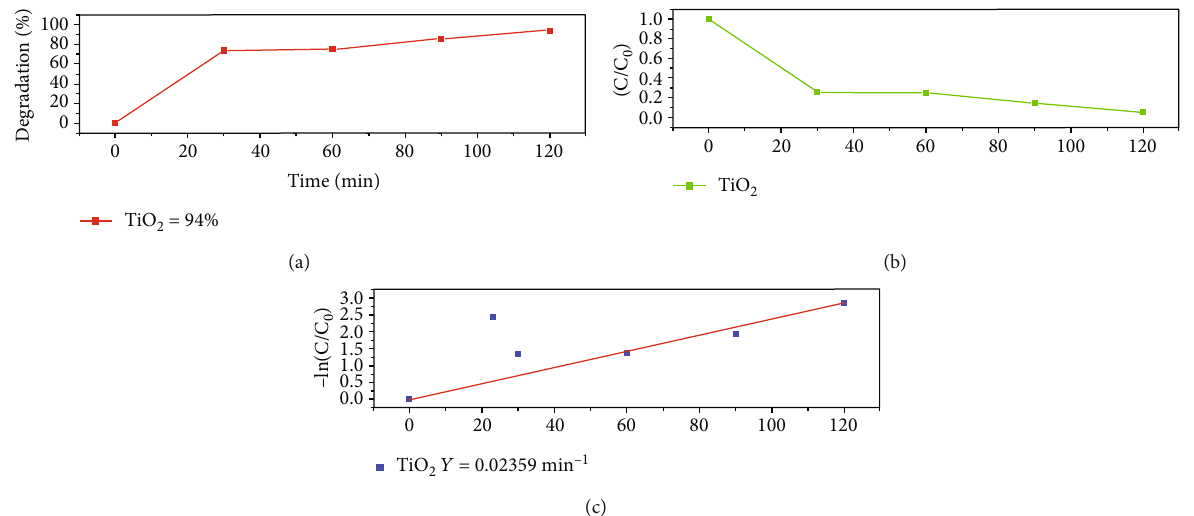
Figure 8: (a) Degradation e ffi cacy of biosynthesized TiO degradation kinetics study of the biosynthesized TiO